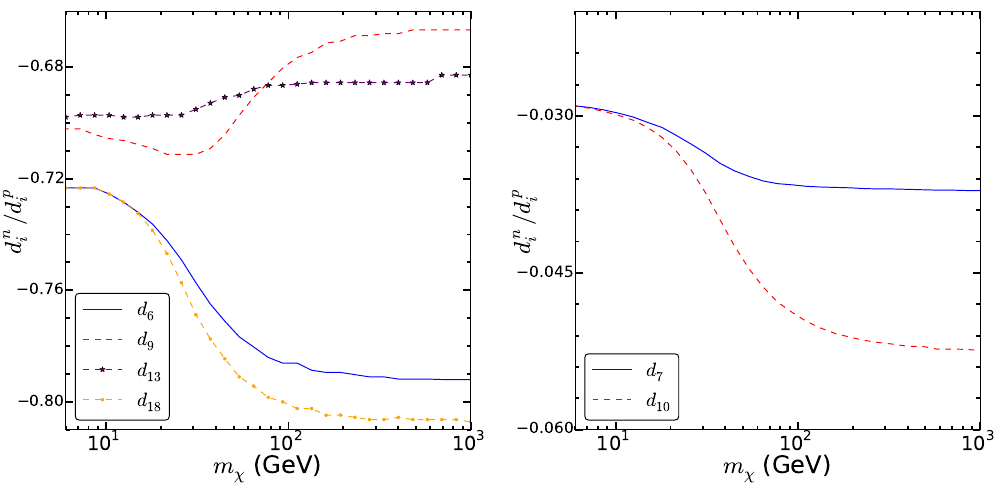
Figure 9 . The neutron to proton coupling ratios at the maximum cancellation for the e(cid:11)ective Lagrangians ( i = 6 ; 7 ; 9 ; 10 ; 13 ; 18).